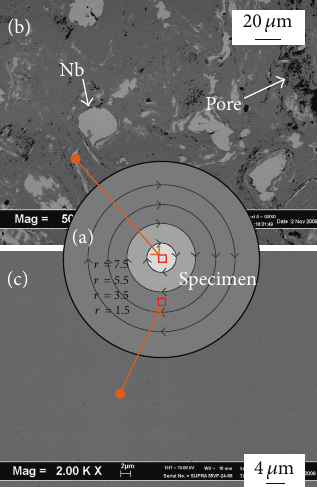
Figure 2: (a) Schematic illustration of microstructural evolution under shear strain and SEM micrographs of the as-HPTed Cu- 15vol%NbC at (b) 0mm and (c) 3.5 mm from the center of the sample.